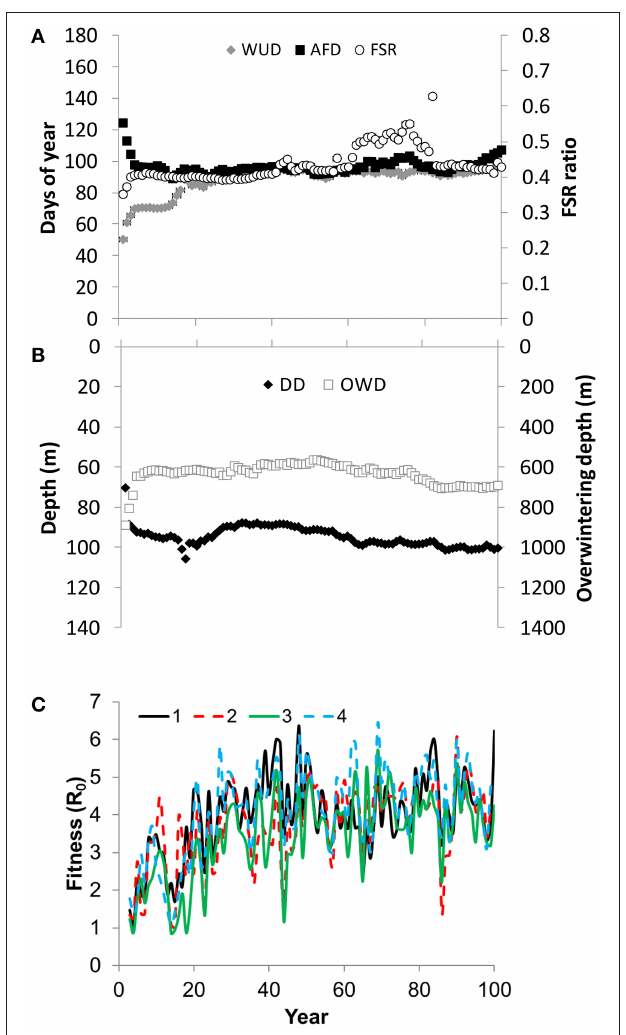
FIGURE 7 | The development over 100 years of the best replicate in simulation 5 in (A) wake up day (WUD), allocation to fat day (AFD) and fat to soma ratio (FSR) traits, (B) the day depth (DD) and overwintering depth (OWD), and (C) fitness (the net reproductive rate, R0) of all four replicates. Values are from end of each year.